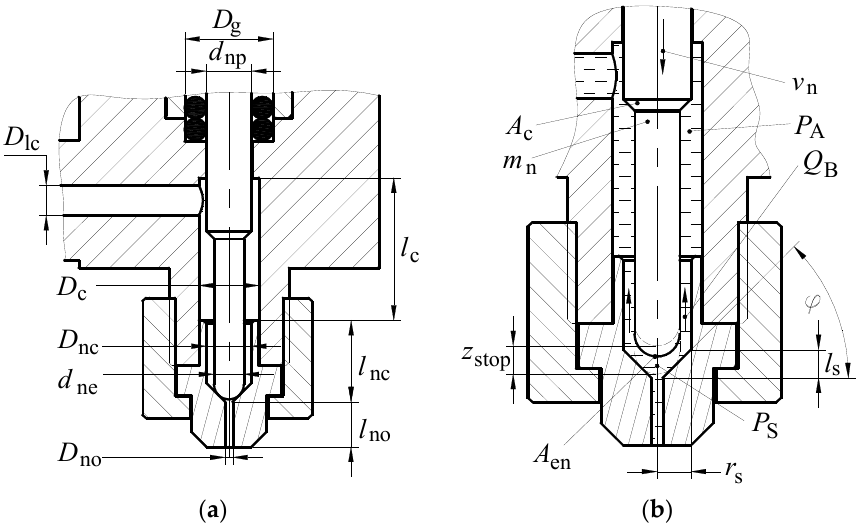
Figure 4. Configuration of dispensing parts. ( a ) Dimensional specifications; and ( b ) dynamic analysis in the dispensing stage.